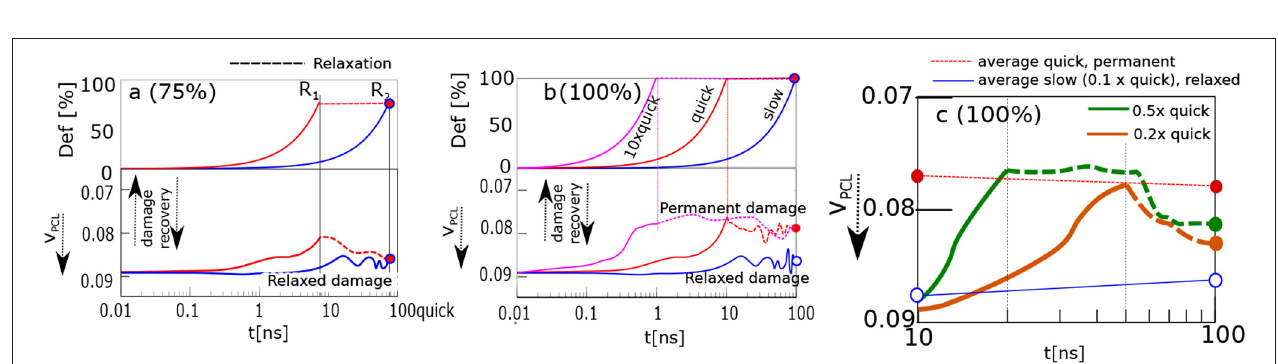
FIGURE 4 | Damage recovery, when the sample is stretched and held in stretched state. Panels correspond to stretching ratios: (a) 75 % ; (b) 100 % , “slow,” “quick,” 10 × “quick”; (c) 100 % 0.2 × “quick,” 0.5 × “quick.” Upper parts of (a,b) display stretching ratio, lower parts—damage, i.e., the inverse volume fraction of physical crosslinks, V PCL . Reference points with the same stretching ratio and simulation time, R 1 —blue, magenta curves, R 2 —all curves.